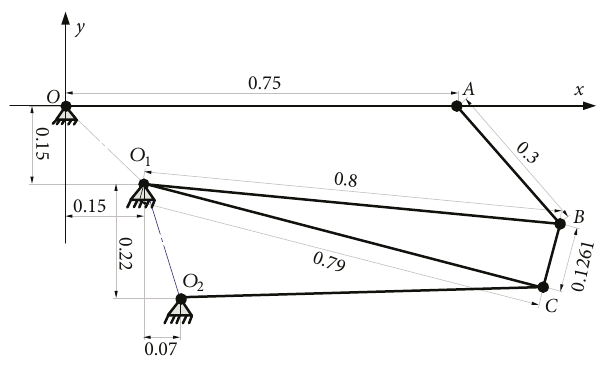
Figure 3: Structure and size of lever-type erection